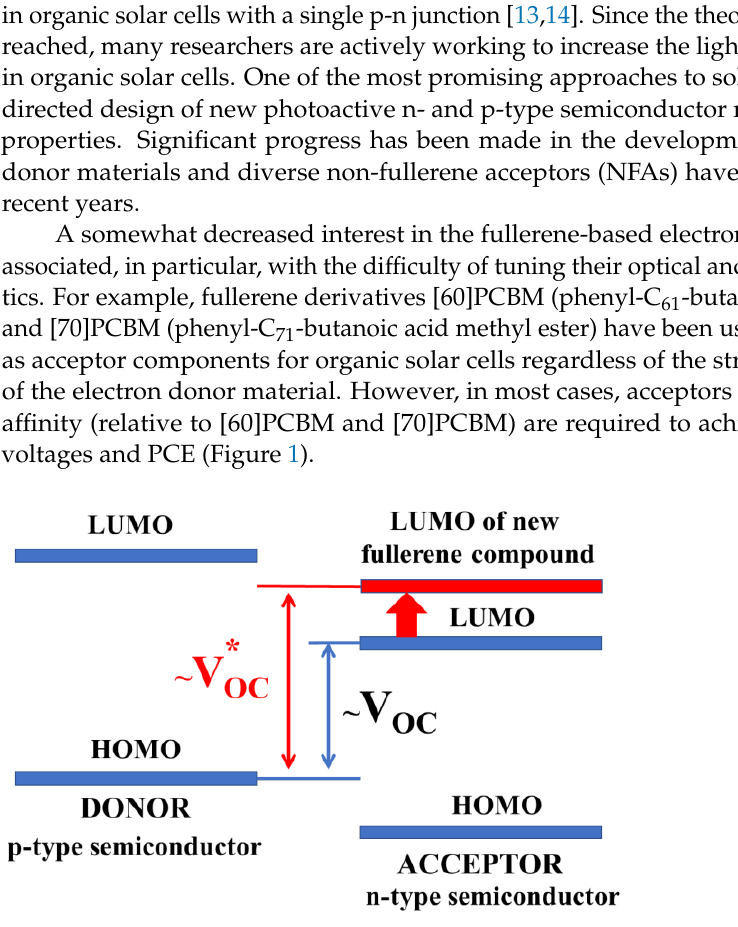
Figure 1. Scheme of the boundary orbitals of the p-type and n-type semiconductor materials in a bulk heterojunction photovoltaic cell. Increasing V OC with an increase in the LUMO energy of the fullerene derivative is shown.